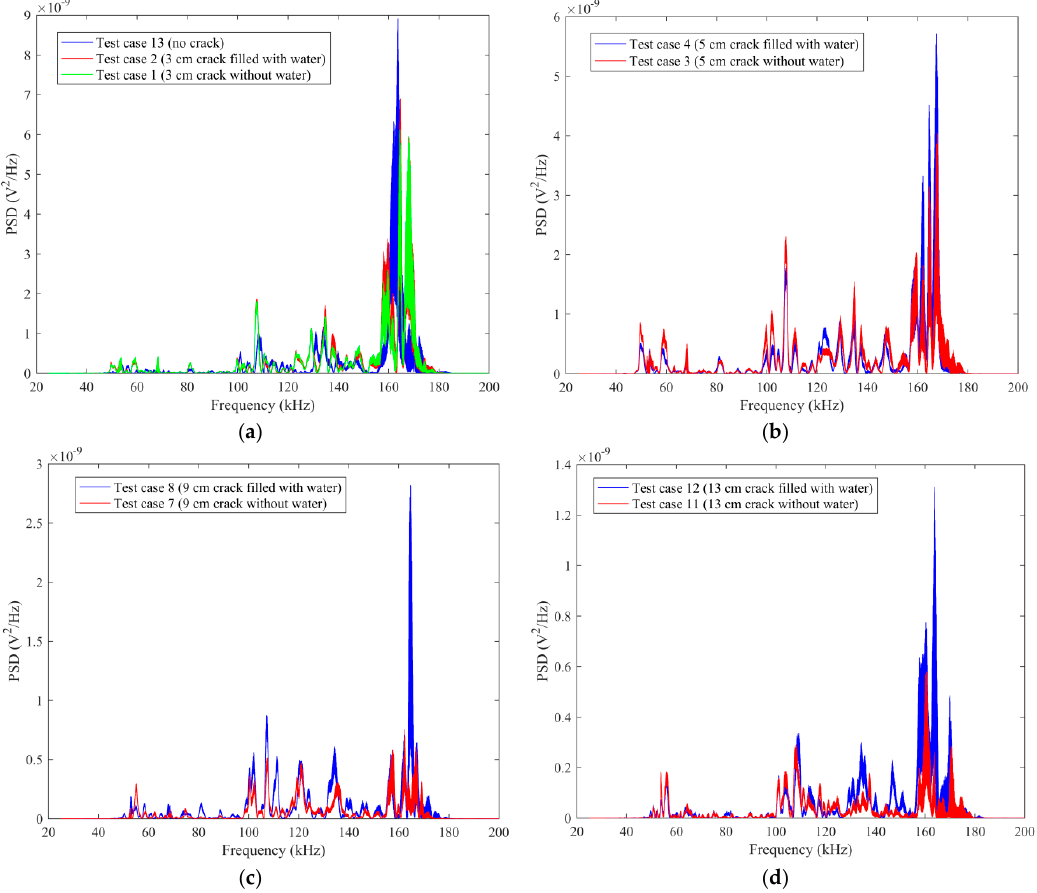
Figure 11. The comparison of Power Spectrum Density (PSD) energy: ( a ) Test case 13 (no crack), test case 1 (3 cm crack without water), test case 2 (3 cm crack filled with water); ( b ) Test case 3 (5 cm crack without water), test case 4 (5 cm crack filled with water); ( c ) Test case 7 (9 cm crack without water), test case 8 (9 cm crack filled with water); ( d ) Test case 11 (13 cm crack without water), test case 12 (13 cm crack filled with